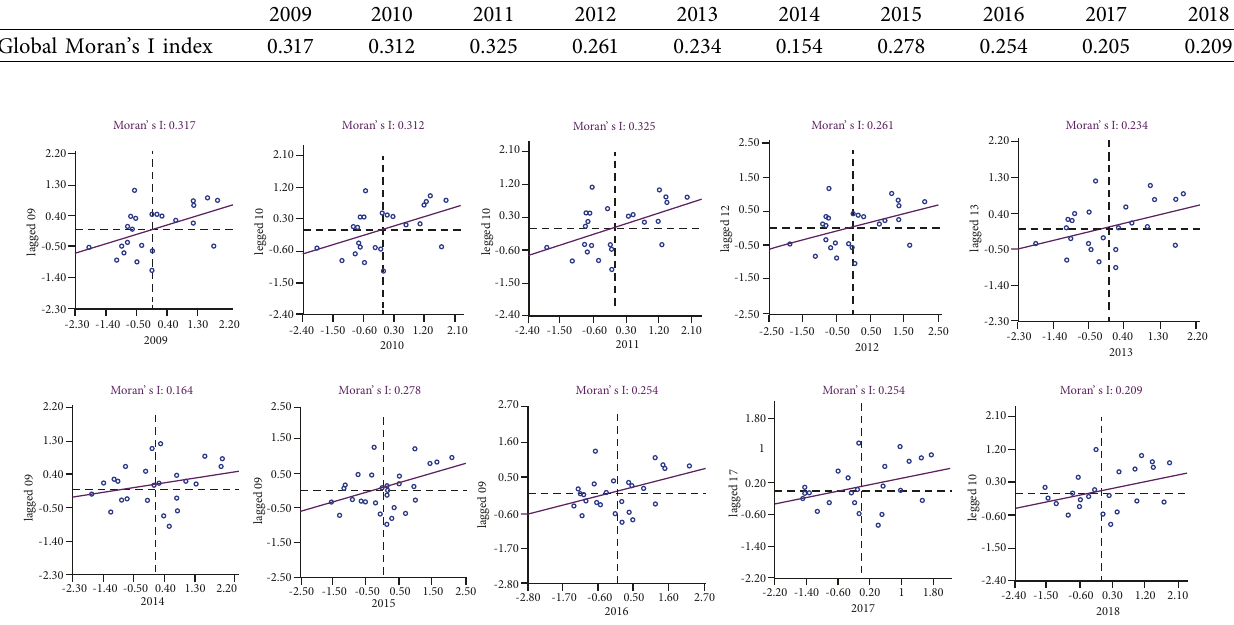
Figure 3: Moran’s I scatter diagram of the coupling coordination degree between technological innovation in the high-tech industry and regional economic